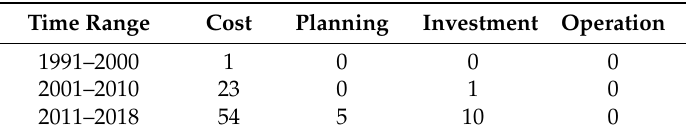
Table 7. The temporal distribution of research